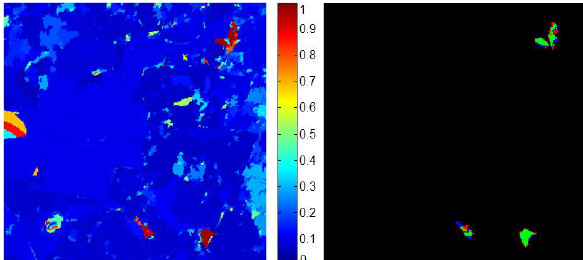
Figure 13: Resulting change map and masks generated in the Oberammergau test area, left:Region-based change probability map (0–1 = 0–100 %), right: Refined mask overlaid with refer- ence data, green: true detected, red: false alarm, blue: missed